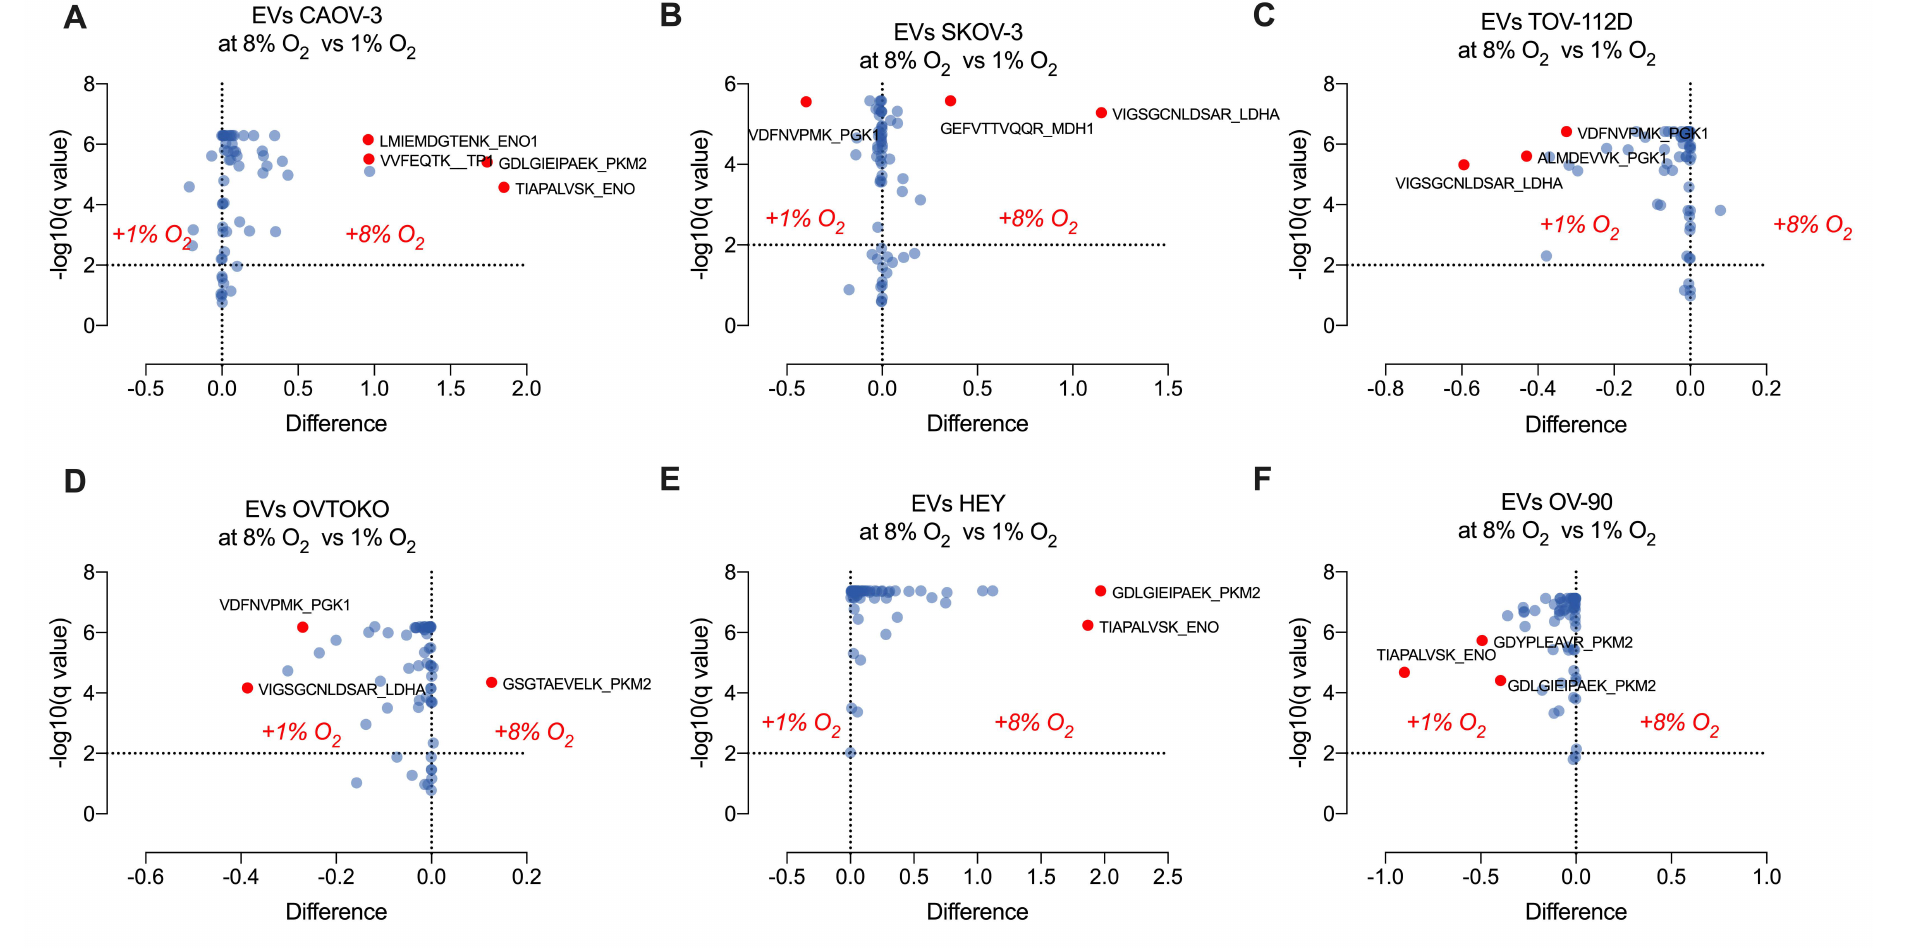
Figure 7. Relative quantification of the glycolysis proteome in sEVs secreted from ovarian cancer cells in response to oxygen tensions. sEVs were isolated from ovarian cancer cells cultured under 8% or 1% oxygen, and the protein abundance associated with glycolysis were quantified using a targeting mass spectrometry approach. ( A ): CAOV-3; ( B ): SKOV-3; ( C ): TOV-112D; ( D ) OVTOKO; ( E ) HEY; and ( F ) OV-90. Volcano plots show the differences in peptides associated with proteins representatives of glycolysis proteome in sEVs from cells cultured at 8% compared with cells cultured at 1%